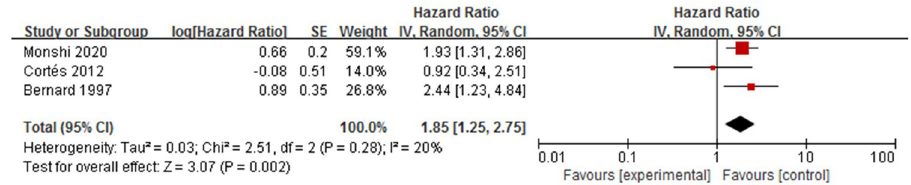
Fig 10. Forest plot of the association between positive bullous pemphigoid 180 antibody and bullous pemphigoid mortality.